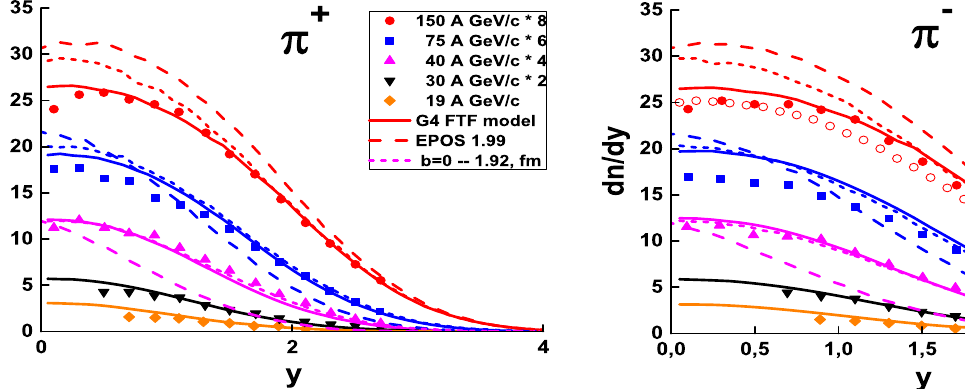
solid lines. The EPOS model predictions are shown by dashed lines. The short dashed lines are the EPOS calculations for b = 0 – 1.92 fm